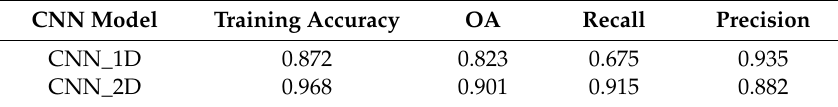
Table 6. Accuracy evaluation based on feature